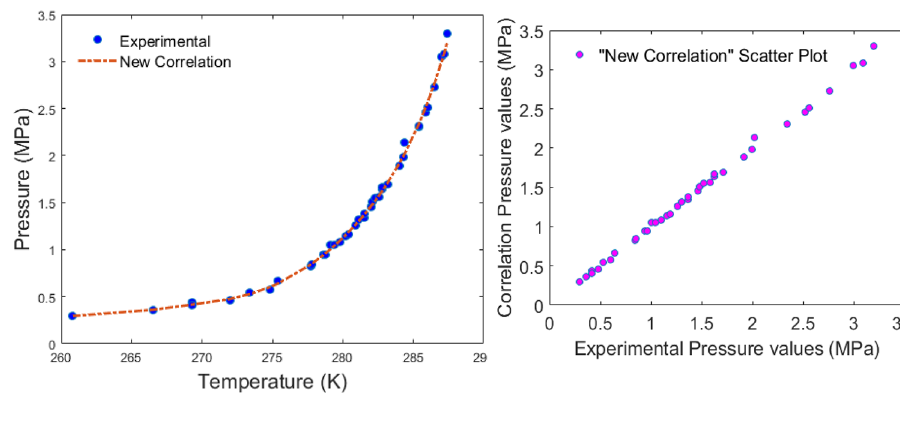
Fig. 16 Peq versus T plot of experimental data (C 2 H 6 hydrates) with “new correla- tion,” AAD = 1.93%